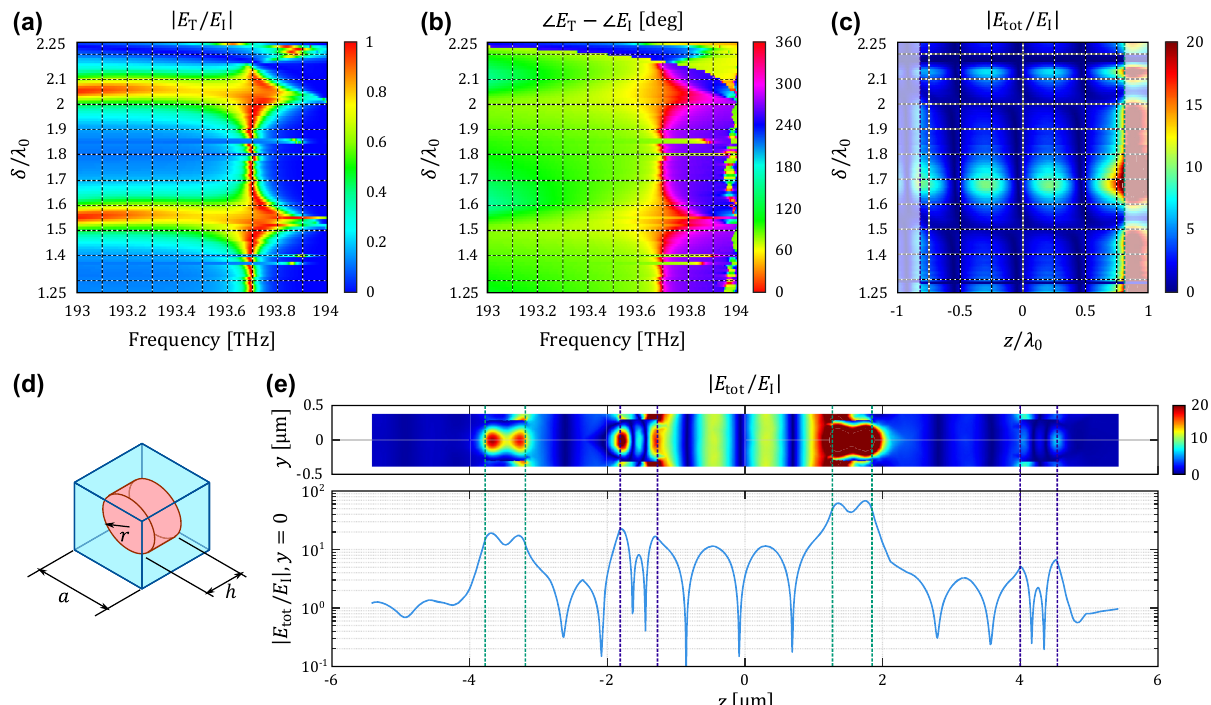
Figure 4: Simulation results for a nested cavity based on nanodisks metasurfaces. (a) After reducing the nanodisk dimensions to their most significant digit, the nested cavity suffers a general drift of the operational frequency. (b) However, the nested cavity remains invisible as the zero-phase difference between the incident and transmitted waves also shifts toward the operational frequency. (c) The nested cavity is able to control the field localized inside the inner cavity as a function of its relative position with the outer one 𝛿 . Peak localization is achieved at 𝛿 electric field around ten times stronger than the incident one. The light-colored regions at the sides of the plot show the fields located inside the nanodisks. (d) The nested cavity was designed from dielectric nanodisk unit cells, with periodicity a , radius r , and height h . The optimized dimensions for the inductive and capacitive metasurfaces are presented in Table 1. (e) A cross-section view of the total electric field distribution across the cavity for this figure) reveals that the localized field in the inner cavity is not affected by the near fields of the nanodisks as long as sufficiently ( 𝛿 = 1.68 𝜆 0 large distance between metasurfaces is chosen. The pairs of dashed lines show the extents and locations of